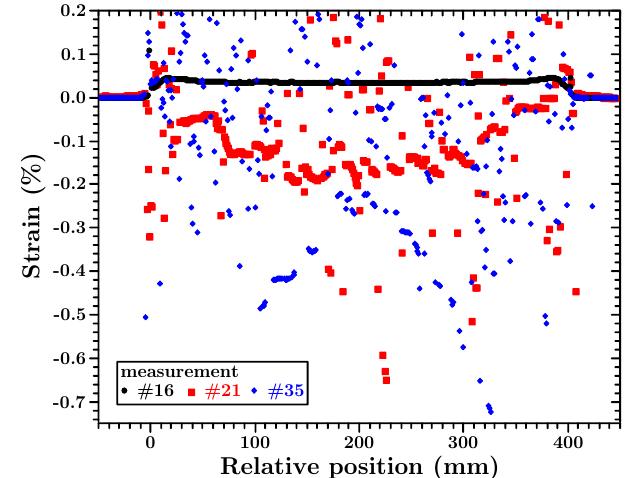
Figure 2. Representative strain data for different states of epoxy cure, determined by utilizing the traditional analysis method (comparing each measurement to the absolute reference record taken before the experiment started). The numbers show the measurement number. For better visualization, the ordinate is cut off at 0.2% strain. Measurement times: #16 → 200min, #21 → 226min, #34 →